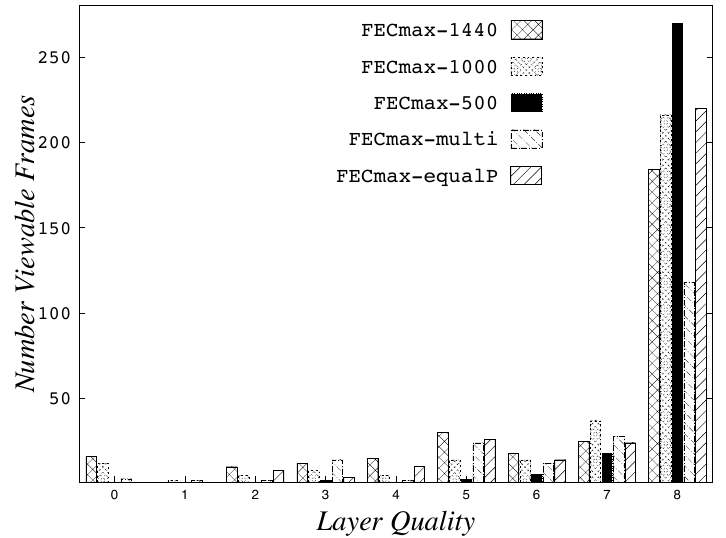
Figure A8. Example of the number of viewable layers for SVC-SC, for each of the FEC max Packet thres , at a packet loss rate of 10%. This image illustrates an increase in the FEC max for C1 and C2 based on the worst case scenario, as shown in Table